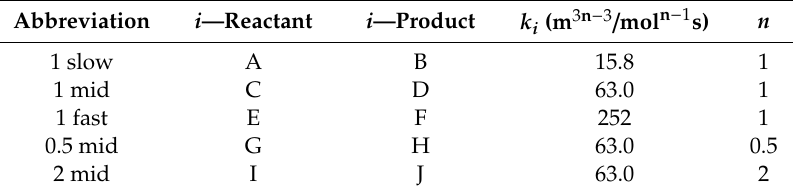
Table A1. Summary of the reactions that were